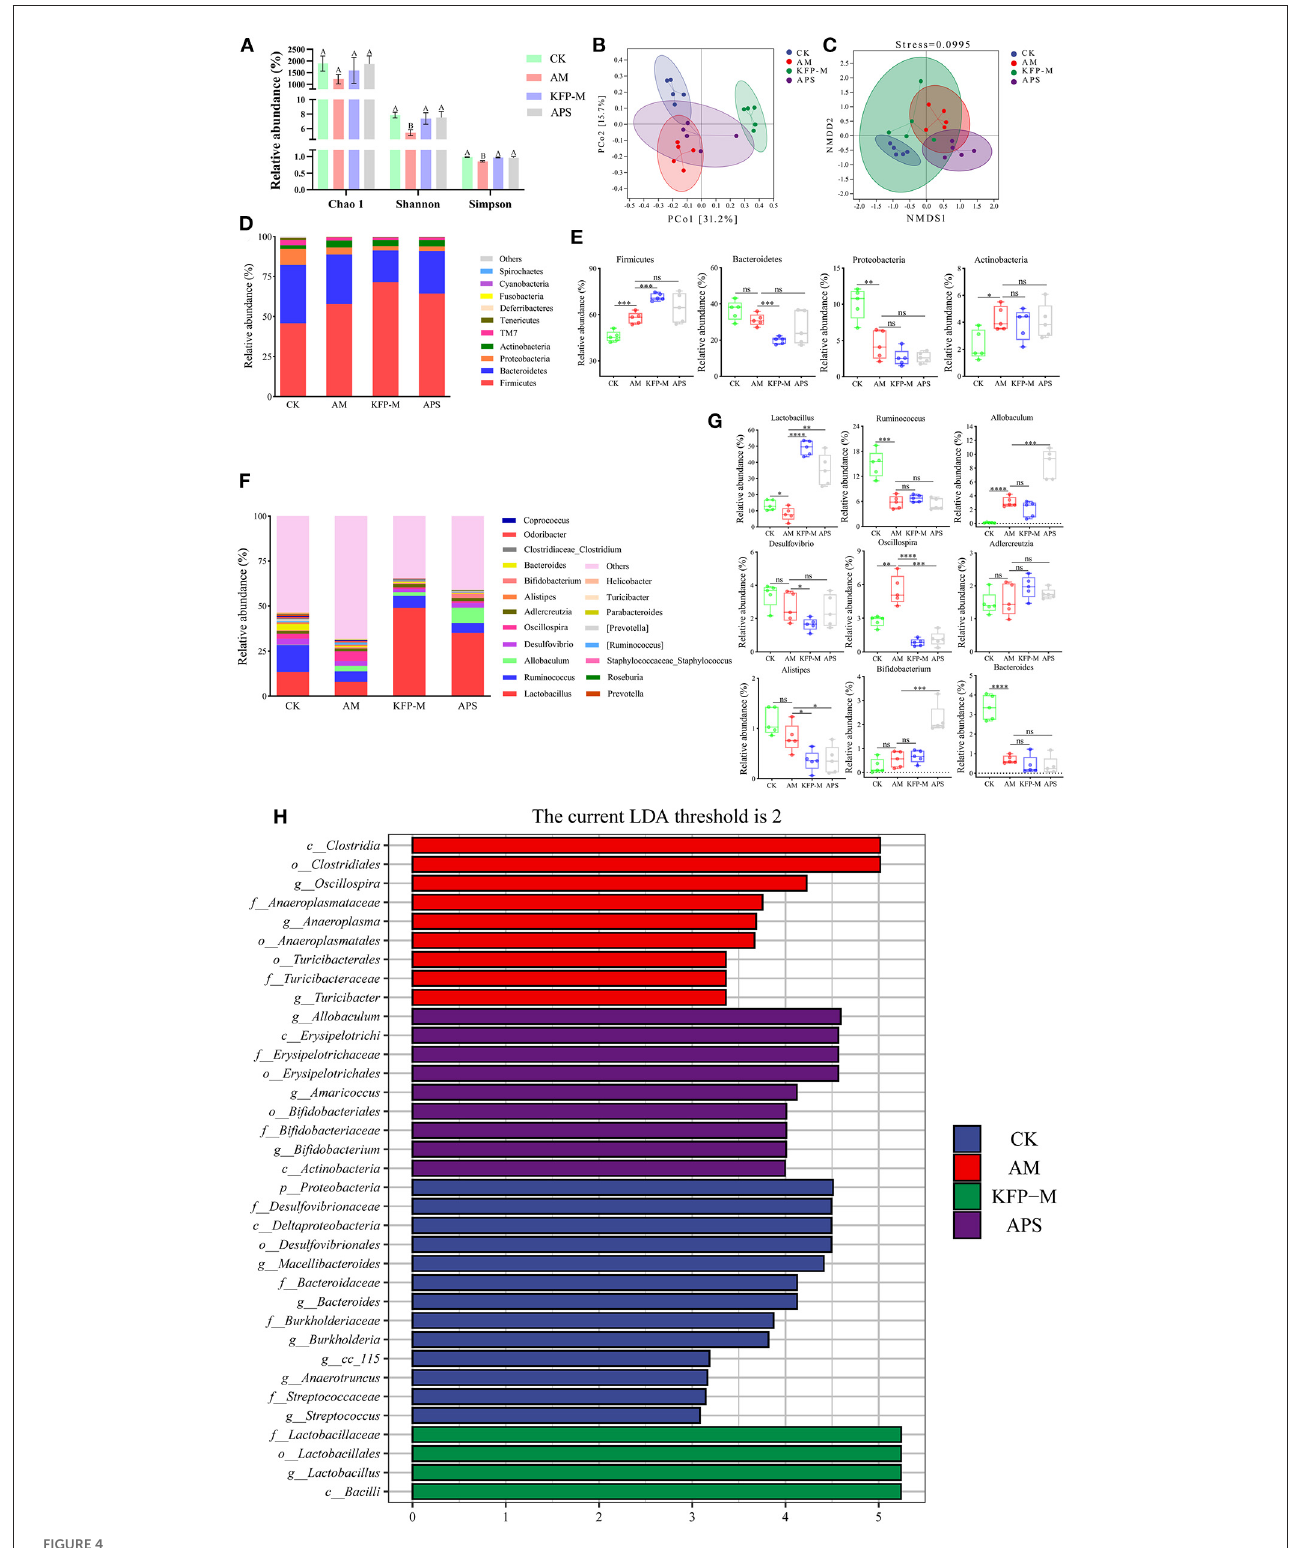
FIGURE4 Effect of KFP on gut microbiota composition in AA-induced mice. (A) Alpha diversity index for gut microbiota from the CK, AM, KFP-M and APS groups presented by Chao1, Shannon and Simpson indices; Different letters indicate significant differences between groups, whereas the same letters indicate no significant differences. A,B P < 0.01 (B) Principal coordinate analysis (PCoA) by Bray-Curtis distance. (C) Non-metric Multidimensional scaling (NMDS) Bray-Curtis distance (stress = 0.0995). (D) The composition of gut microbiota bar plot analysis on phylum levels. (E) The relative abundances of Firmicutes, Bacteroidetes, Proteobacteria and Actinobacteria in CK, AM, KFP-M and APS groups were contrasted by Student’s T -test with significant difference between groups represented as **** p < 0.0001, *** p < 0.001, ** p < 0.01, * p < 0.05 and ns represent no significant difference on phylum level. (F) The gut microbiota composition bar plot analysis on genus levels. (G) The relative abundances of Lactobacillus , Ruminococcus , Allobaculum ,